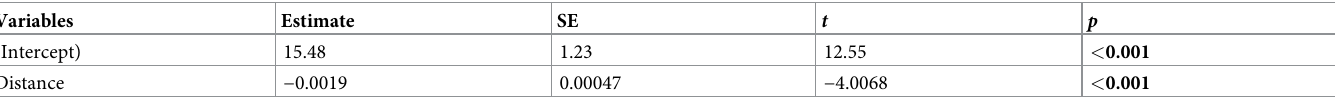
Table 3. Model 4. The relationship between insect-eating bird abundance and forest